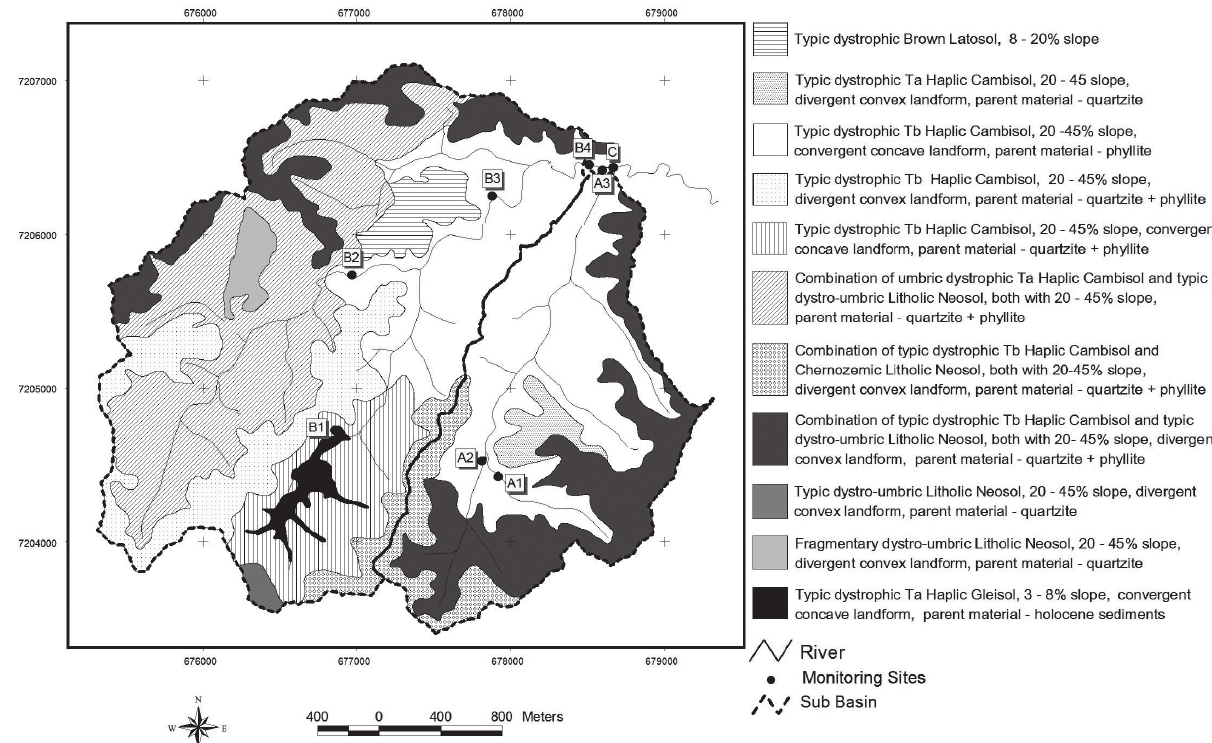
Figure 1. Soil units in the Campestre